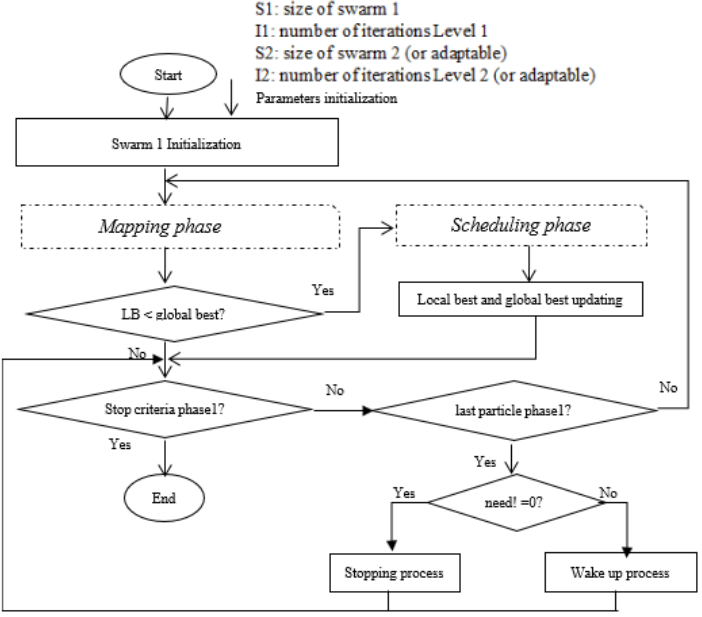
Figure 4. Flowchart of the embedded two-level PSO